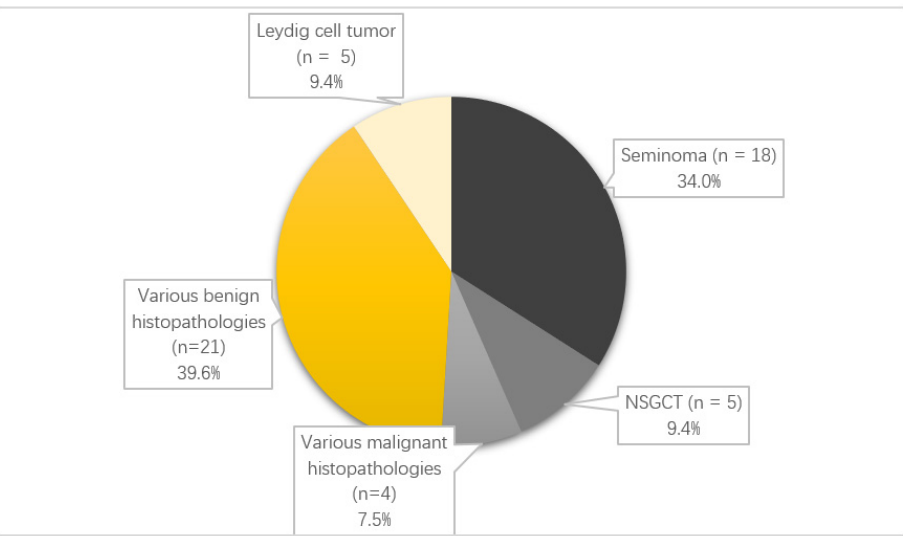
Figure 1. Distribution of histopathology ( n = 53; various malignant histopathologies: adenocarcinoma of the rete testis, liposarcoma of the spermatic cord, myeloid sarcoma of the testis and pancreatic analogous solid-pseudopapillary neoplasm of the testis; various benign histopathologies: infection ( n = 4), residual fibrosis after chemotherapeutically pretreated teratoma ( n = 1), normal testicular tissue ( n = 5), sclerosis/fibrosis ( n = 2), Sertoli cell hyperplasia/tumor ( n = 2), Leydig cell hyperplasia ( n = 1), atrophy ( n = 4), hematoma ( n = 1) and St. p. testicular torsion ( n =